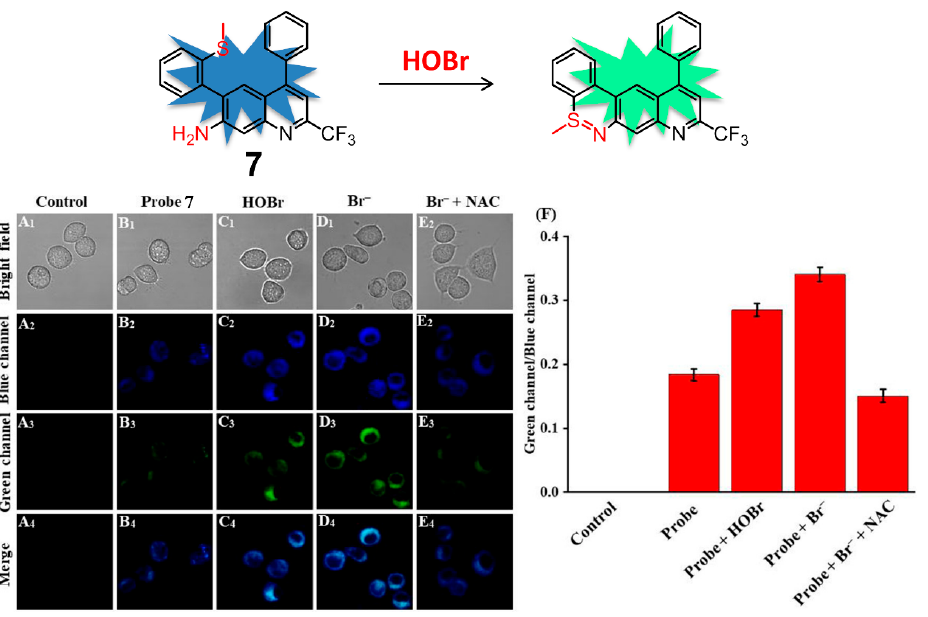
Figure 8. Ratiometric fluorescence probe 7 for HOBr (top) and its fluorescence imaging of HOBr in RAW 264.7 cells (down). Cells were incubated with ( A ) control; ( B ) probe 7 ; ( C ) probe 7 then treated with HOBr (50 μ M); ( D ) probe 7 then treated with NaBr (100 μ M); ( E ) NaBr (100 μ M) and NAC (100 μ M, a scavenger of HOBr) then treated with probe 7 ; ( F ) Fluorescence intensity ratios (F green /F blue ) from ( A – E ). Blue channel: 455 nm–505 nm, green channel: 545 nm–645 nm, λ ex = 434 nm. Reproduced with permission from Reference [83]. Copyright 2020 Elsevier.